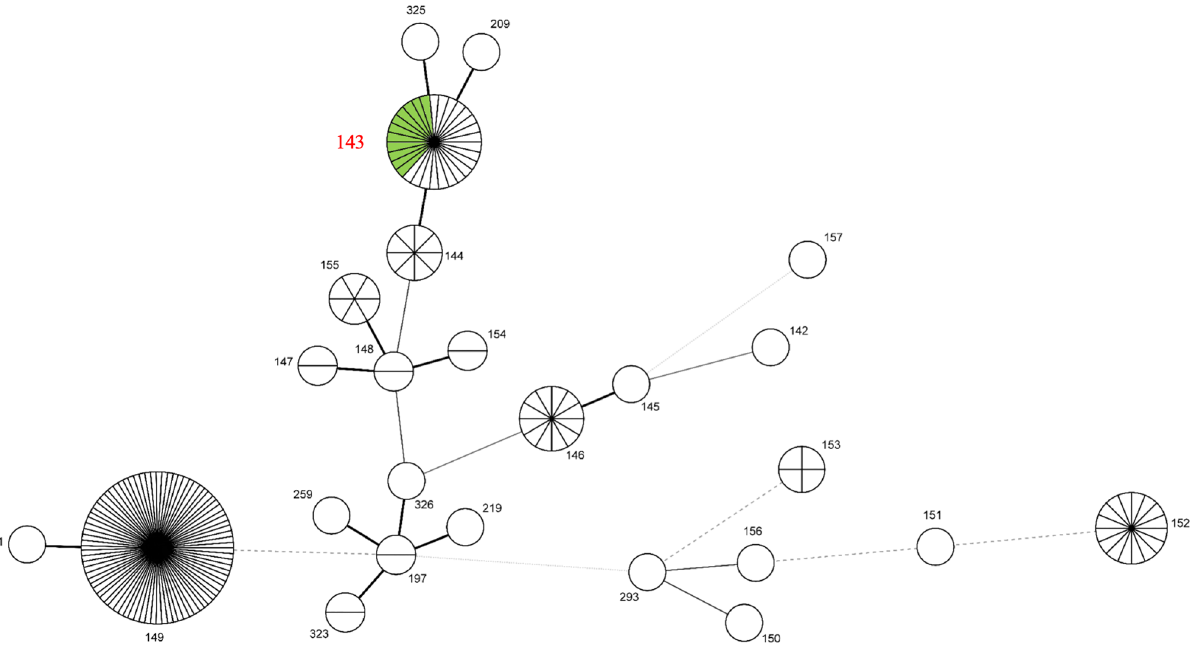
Figure 1. MST of L. borgpetersenii detected from cat urine samples and L. borgpetersenii serogroup Javanica strains in this study and 182 L. borgpetersenii strains based on the allelic profiles of the MLST seven housekeeping genes. Each circle represents an individual ST, and the numbers represent ST numbers. Circle sizes correspond to the numbers of strains in each ST. The thickness and the dotting of lines indicate the distance between the circles: a thicker line indicates a closer distance than a thin line, and a thin line denotes a closer distance than a dotted line. The green-colored circle and the ST number in red represent L. borgpetersenii serogroup Javanica strains and DNAs determined in this study.